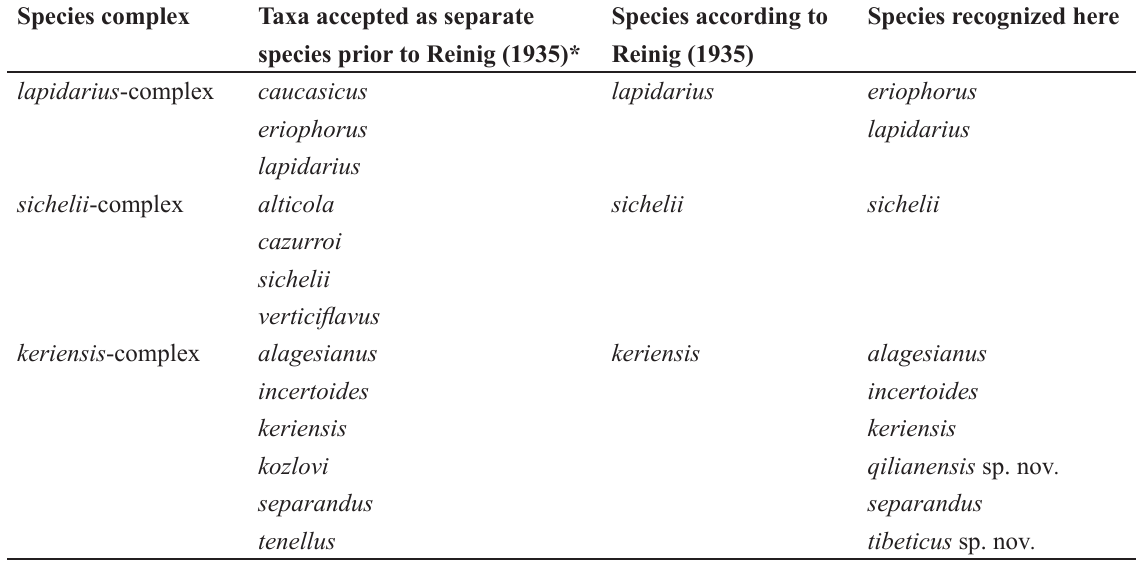
Table 1. Taxa interpreted as species for three species-complexes (left) before Reinig (1935), by Reinig (1935), and from the integrated assessment here. (Note that the taxa qilianensis and tibeticus are not equivalent to the taxa kozlovi and tenellus